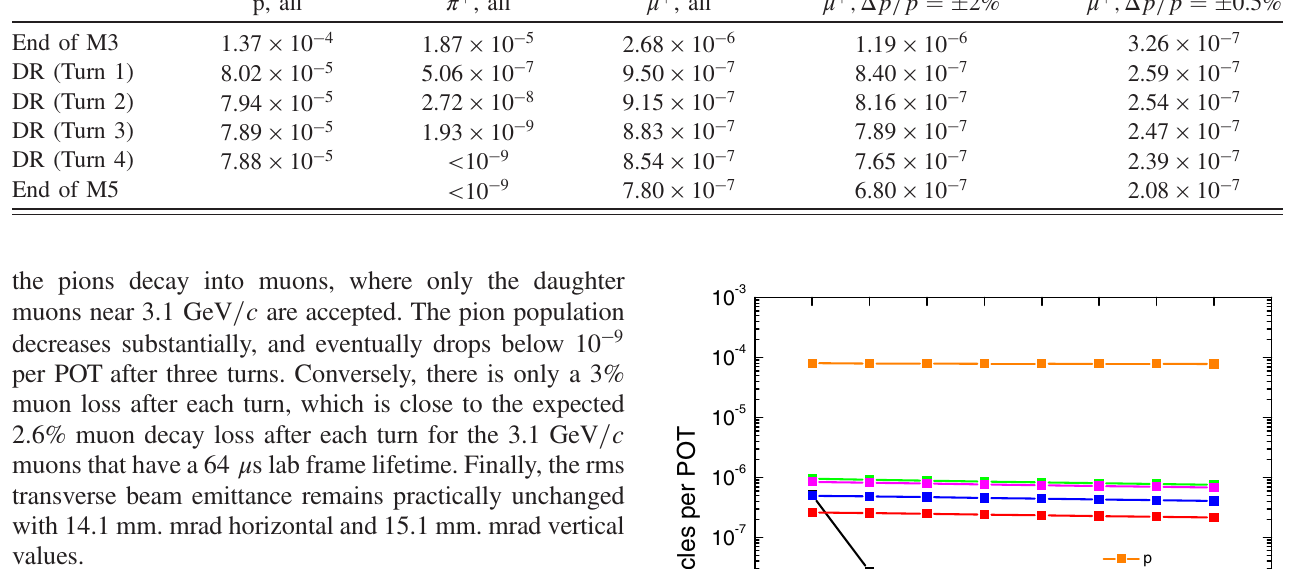
TABLE II. Number of secondary particles at different Fermilab Muon Campus locations, where these values are normalized to the POT. p, all